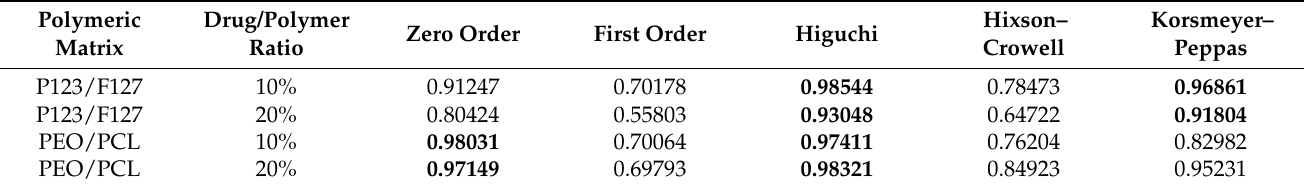
Table 6. R -values for different drug release model